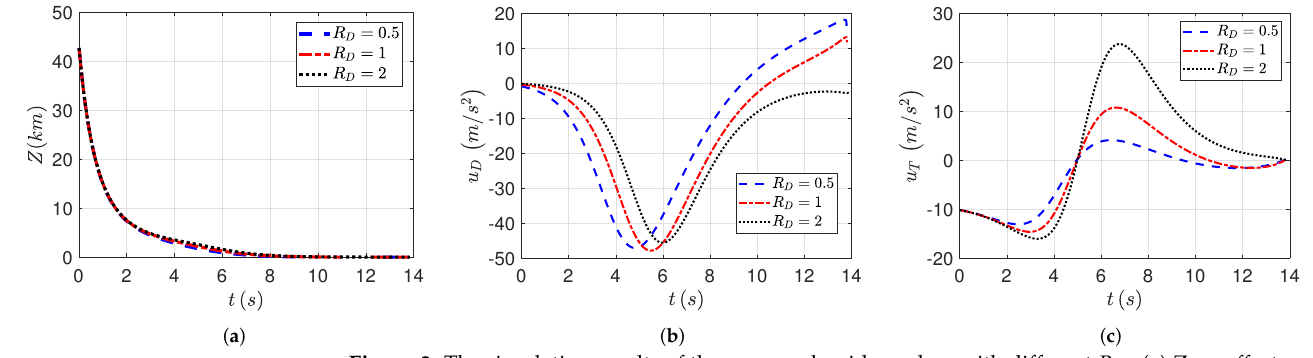
Figure 3. The simulation results of the proposed guidance law with different R D . ( a ) Zero-effort error distance, ( b ) Guidance command of defender, ( c ) Guidance command of target.